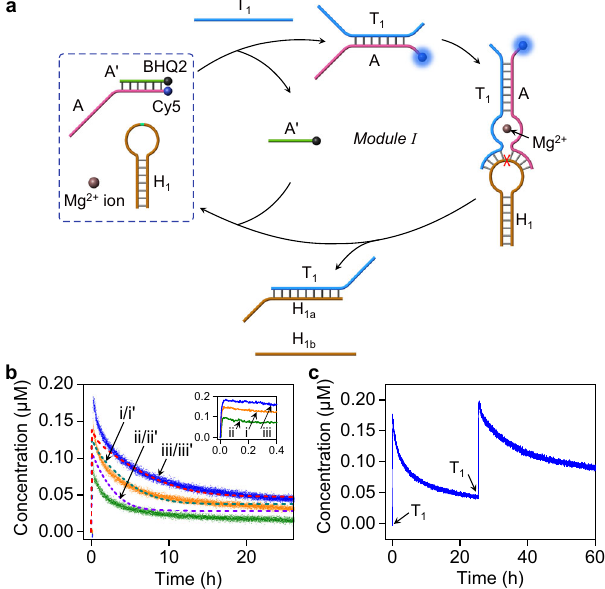
Fig. 1 | Triggered transientformation anddepletionofa DNAzyme.a Triggered transientoperationofareactionmoduleconsistingofduplexA/A ’ (0.2 μ M),hairpin H 1 (1 μ M) and Mg 2+ -ions, resulting in a Mg 2+ -ion-dependent DNAzyme T 1 /A. b Transient concentrations corresponding to: (i)-solid line, the formation and depletion of the Mg 2+ -ion-dependent DNAzyme T 1 /A in the presence of trigger T 1 =0.3 μ M, and (i ’ )-dashed line, computationally-simulated transient using the kinetic model presented in Supplementary Fig. 2. Transient and computational predictedcurves(ii)/(ii ’ ),correspondingtotheT 1 -triggeredformation/depletionof DNAzyme T 1 /A in the presence of T 1 =0.2 μ M, and (iii)/(iii ’ ) transient and compu- tationallypredictedcurves,correspondingtotheformation/depletionofDNAzyme T 1 /A in the presence of T 1 =0.4 μ M. Insert: Time dependent dynamic evolution of T 1 /A at short time intervals: (i) in the presence of trigger T 1 =0.3 μ M, (ii) in the presence of trigger T 1 =0.2 μ M, (iii) in the presence of trigger T 1 =0.4 μ M (For the half-life values of the transients, see Supplementary Fig. 6.). c Cyclic operation of thetransientDNAzymecycle(T 1 =0.4 μ M)shownin a .Arrowsindicatetheaddition of the trigger T 1 . Source data are provided as a Source Data fi